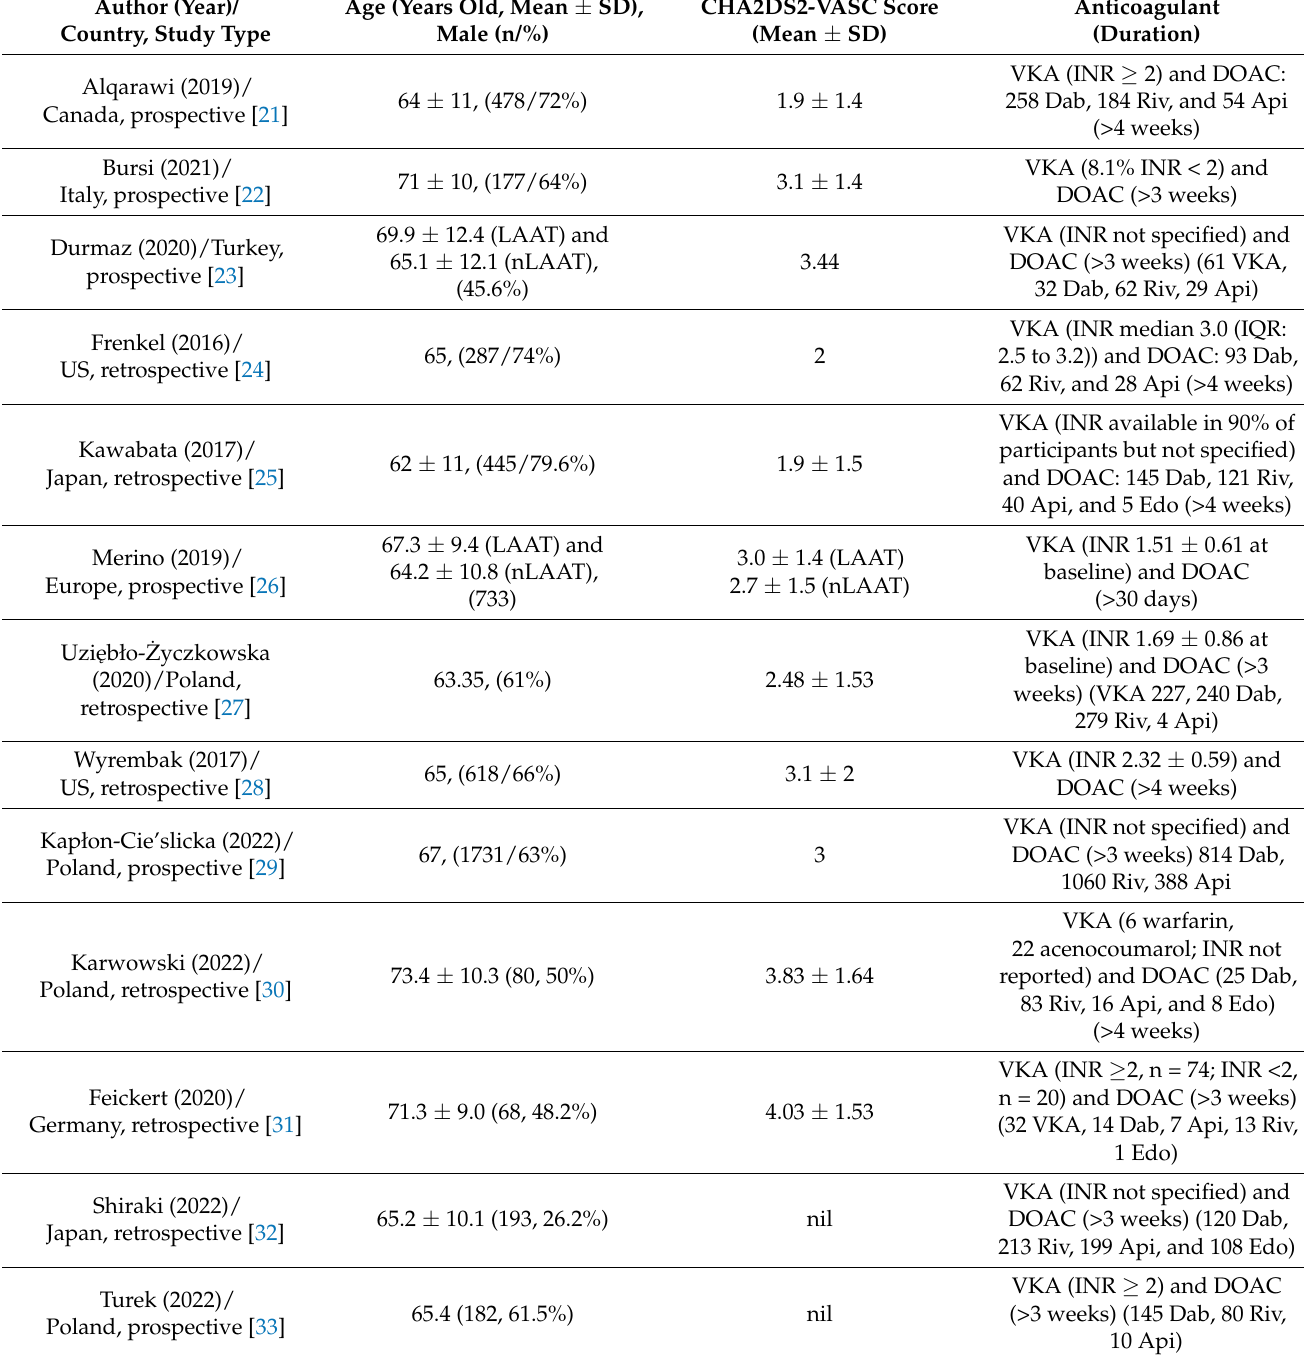
Table 1. Baseline characteristics of included studies for systematic review and meta-analysis of the incidence of left arterial appendage thrombus (LAAT) in patients with atrial fibrillation under vitamin K antagonist (VKA) or direct oral anticoagulant (DOAC)